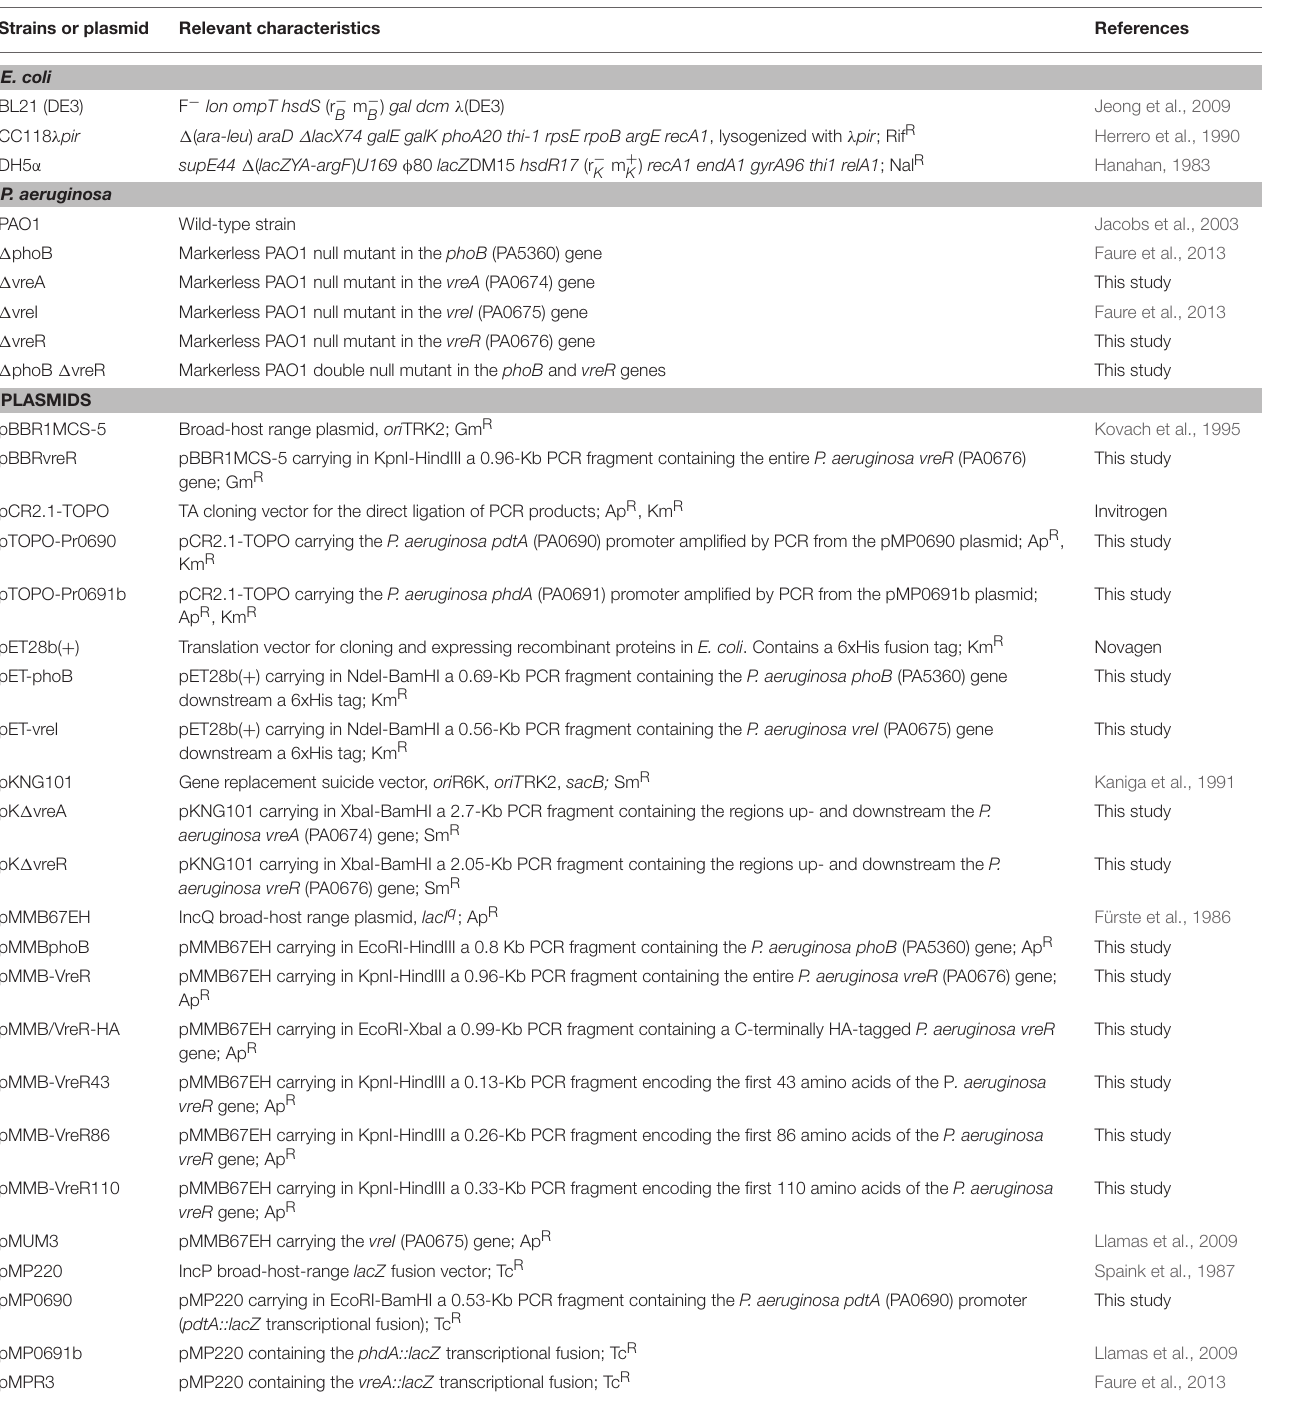
TABLE 1 | Bacterial strains and plasmids used in this study a . Strains or